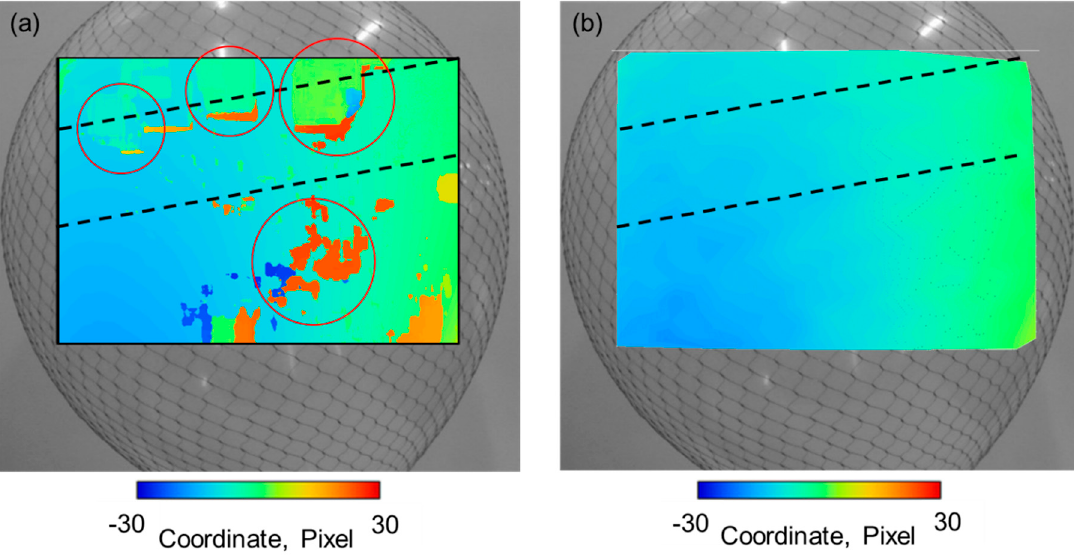
Figure 8. Horizontal displacement distribution by ( a ) DIC; ( b ) SiDIC, on the photograph of net covered balloon.